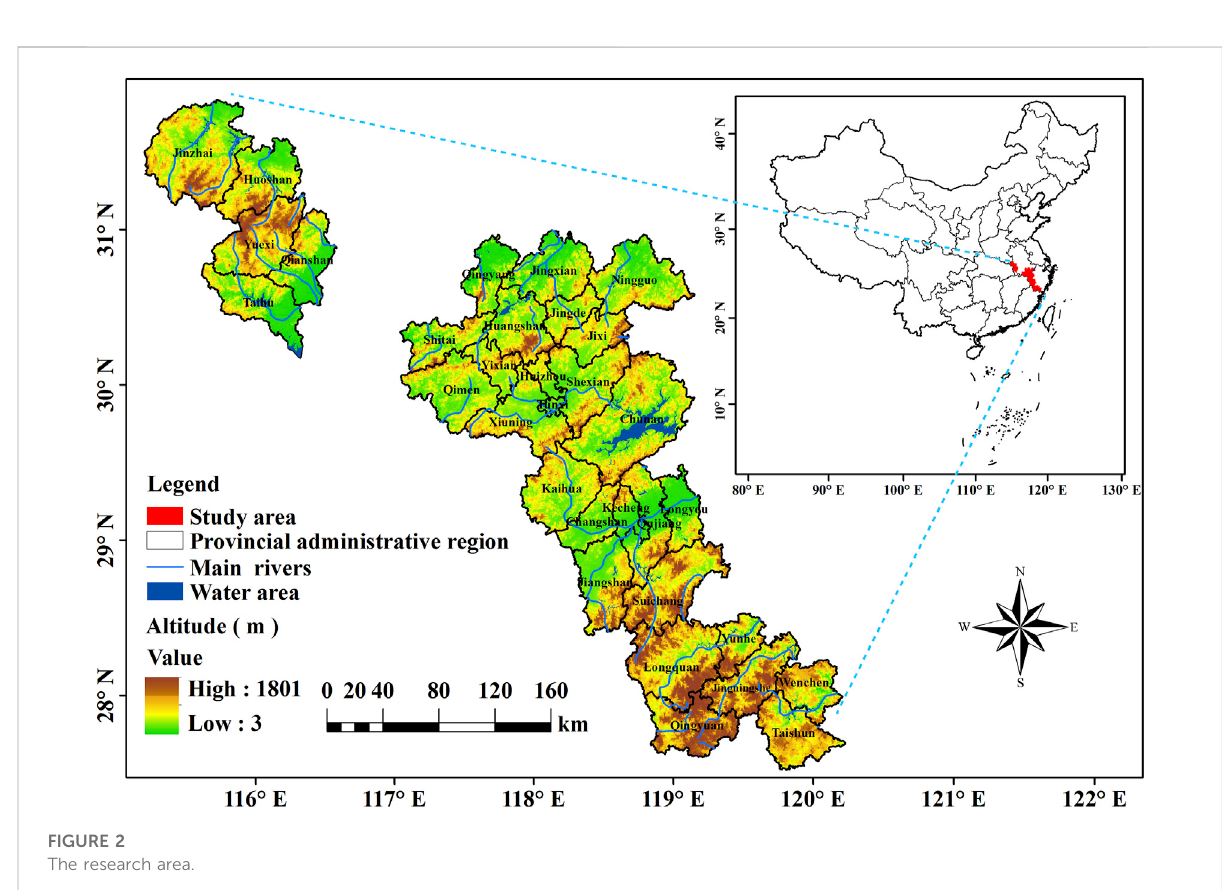
FIGURE 2 The research